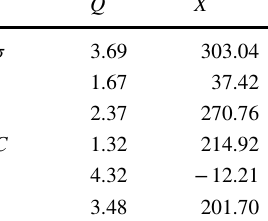
Table 2 Optimal parameters of Gaussian membership functions in trade-off